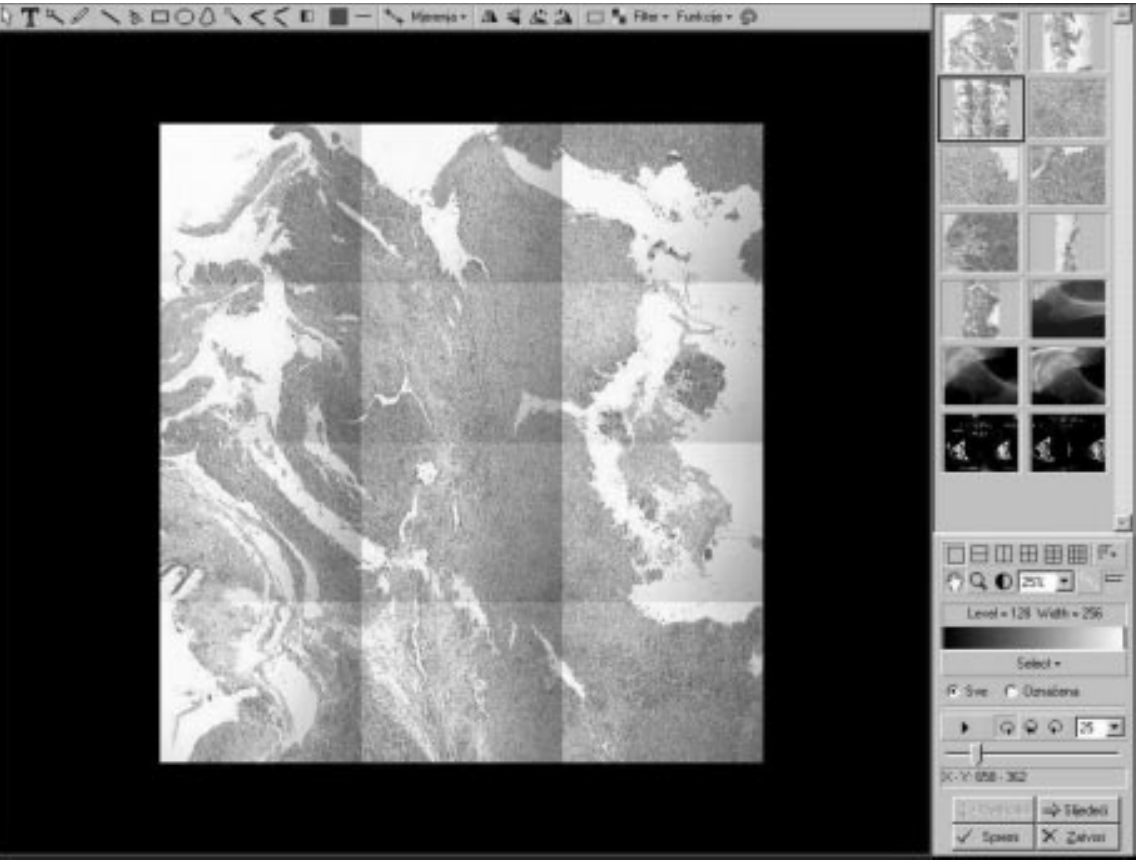
Fig. 2. Patchwork image consisting of 12 full-size high quality images. Each image can be expanded to full screen